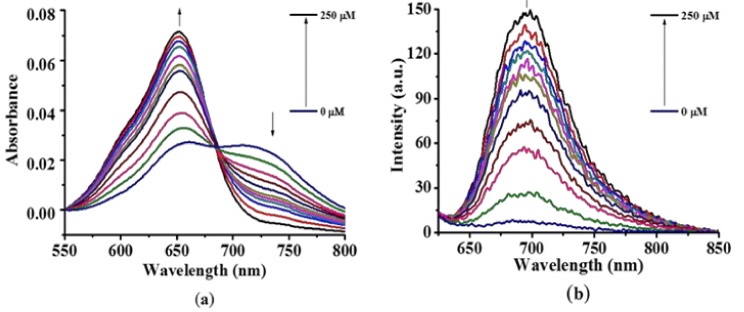
Figure 4. ( a ) Absorption and ( b ) fluorescence emission spectra of compound 7 (1 µ M) with different concentration of H 2 O 2 in solution (PBS/DMSO = 4:1, v / v ; 10 mM, pH =